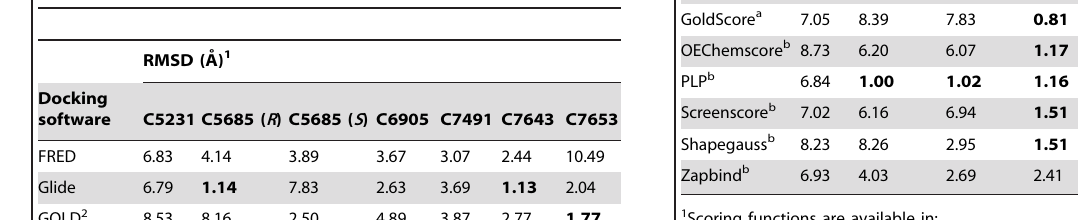
Table 5. RMSD values of poses generated by molecular docking simulations of AChE inhibitors using default parameter settings.